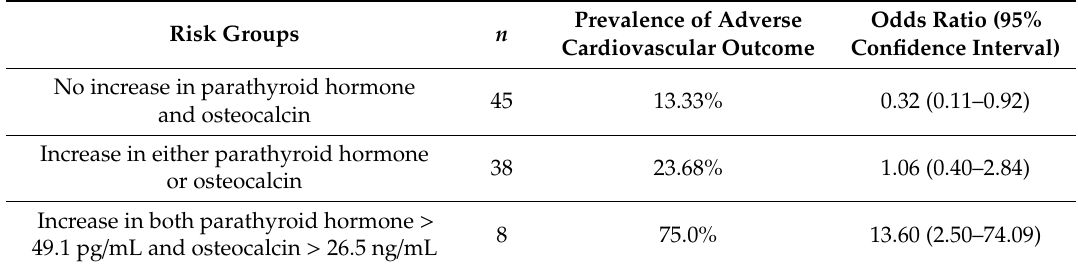
Table 9. Prevalence of an adverse cardiovascular outcome and odds ratios in relation to the combinations of risk factors ( р =